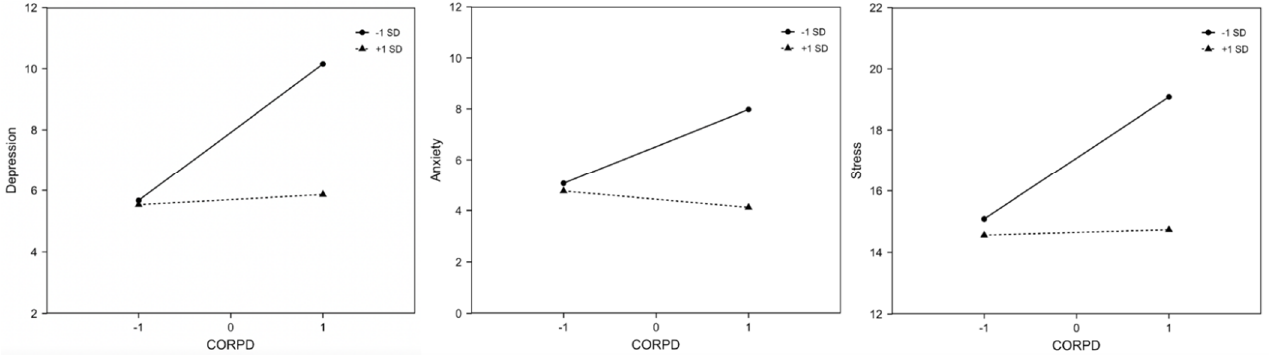
Figure 2. Moderation effect of family resilience between pandemic-related psychological distress and depression, anxiety and stress severity. Note: SD = standard deviation; CORPD = COVID-19-related psychological distress